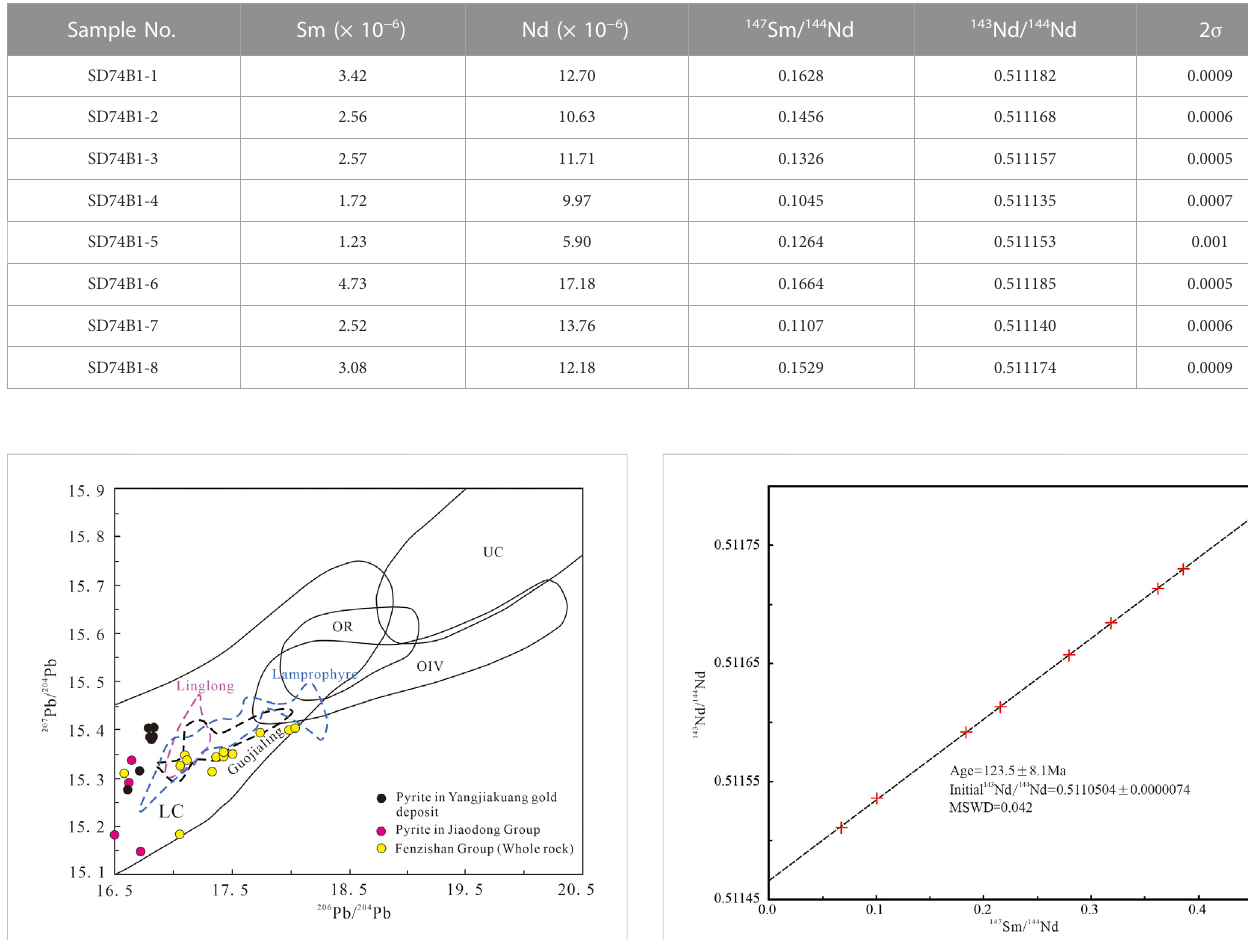
FIGURE 10 206 Pb/ 204 Pb – 207 Pb/ 204 Pb diagram of the Yangjiakuang gold deposit (after Zartman & Doe,